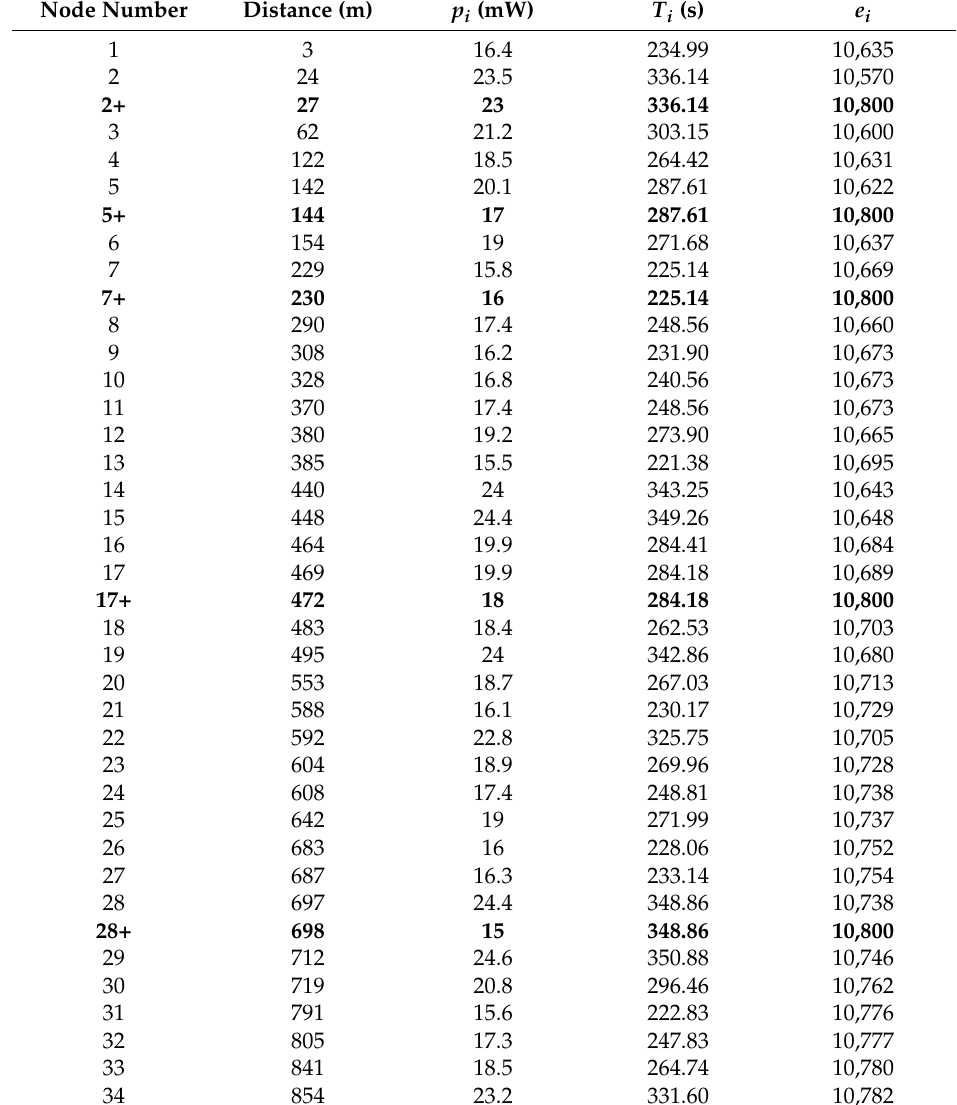
Table 2. Nodes information in subnetwork one in the first